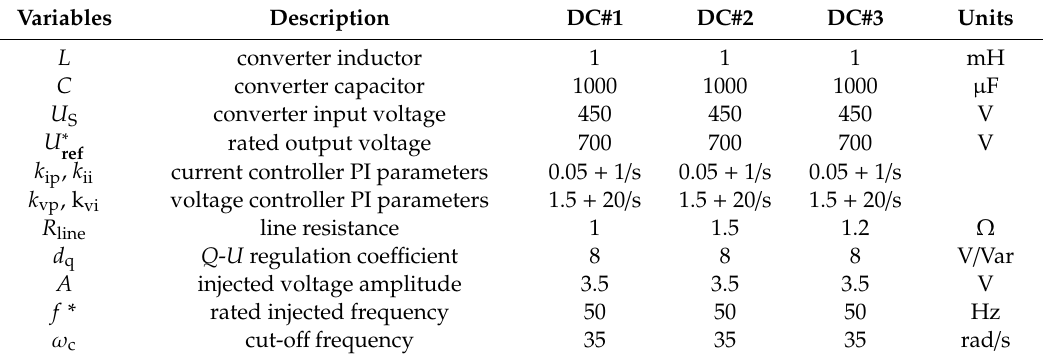
Table 1. The parameters of the paralleled DC / DC